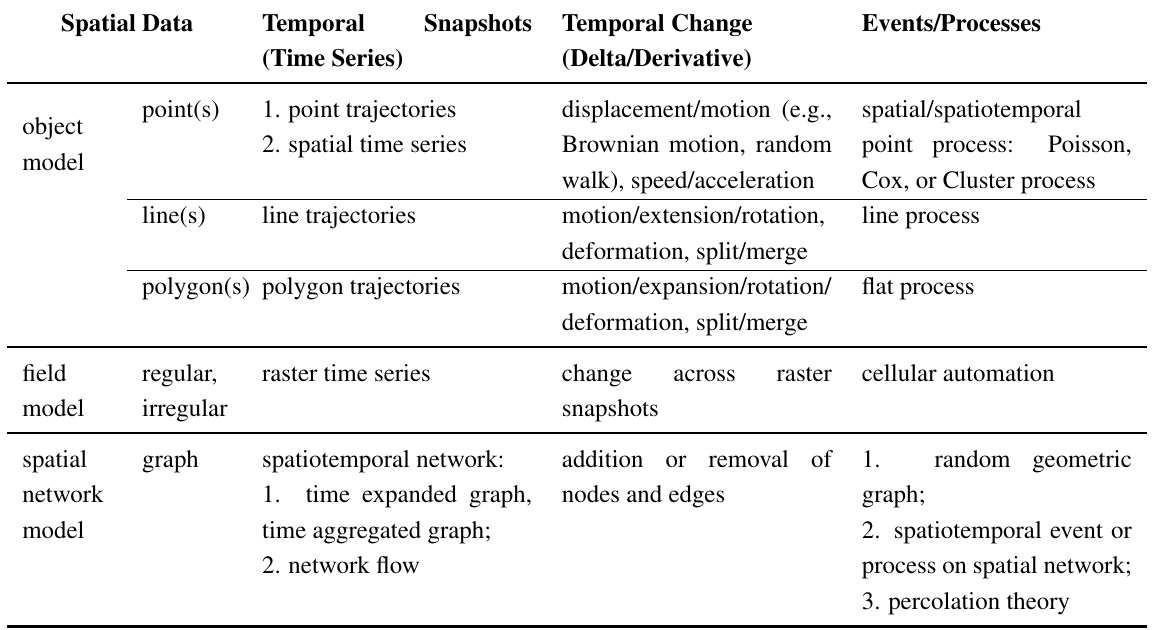
Table 1. Taxonomy of Spatial and Spatiotemporal Data